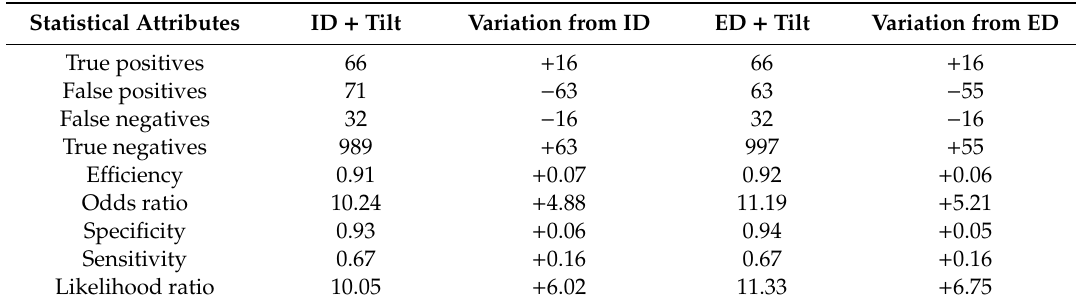
Table 4. Prediction performance of algorithm-based approach, using empirical rainfall